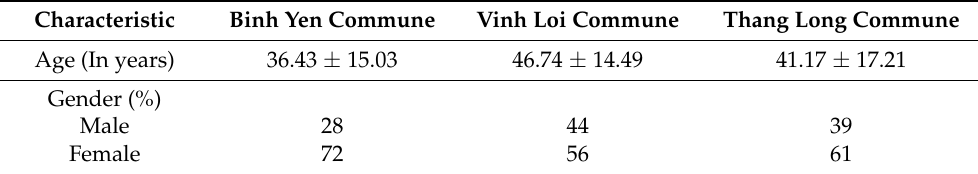
Table 2. Demographic characteristics of the research